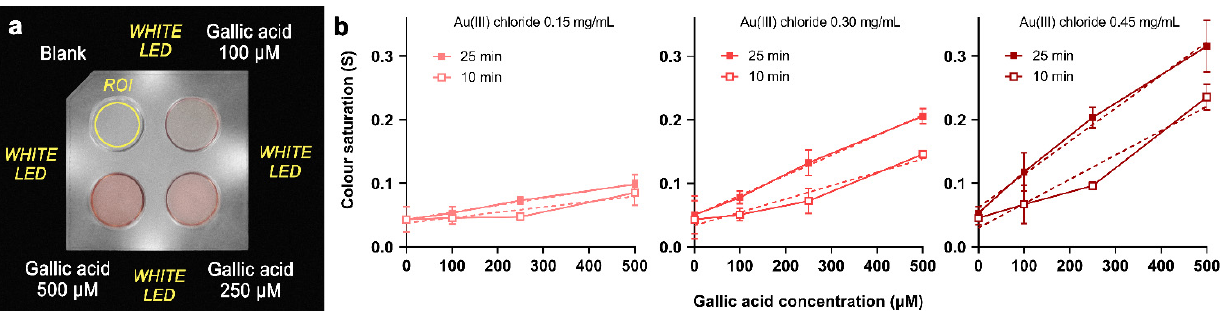
Figure 2. ( a ) Image of the analytical cartridge taken during the analysis; ( b ) Calibration curves obtained after 10 and 25 min of incubation in analytical cartridges prepared using 0.15, 0.30, and 0.45 mg/mL of Au(III) chloride. The dashed lines represent the linear regression fitting of the experimental data. Each point is the mean ± SD of three experiments.